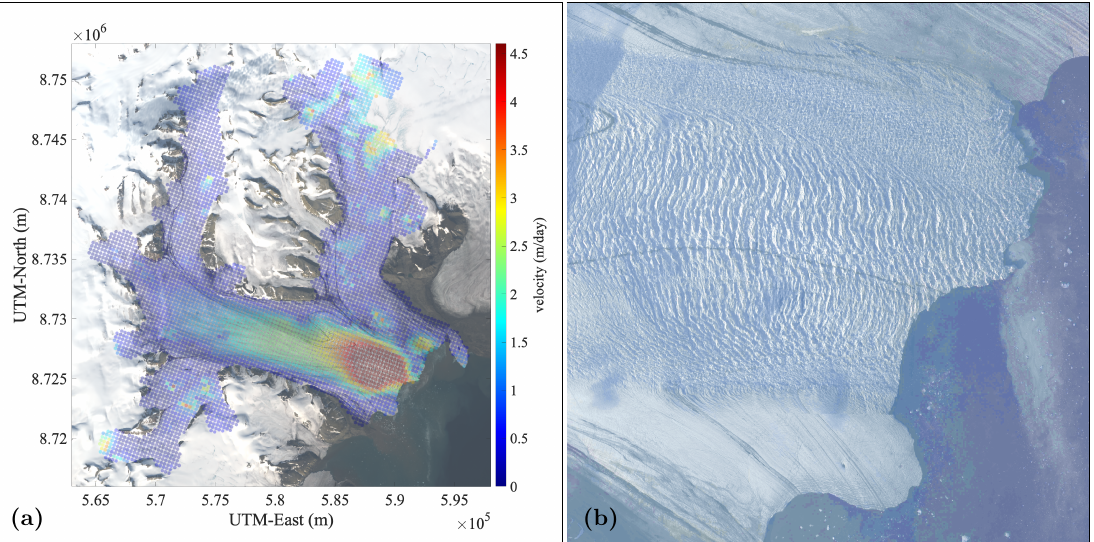
Figure 4. Negribreen velocity magnitude and crevassing at time of validation campaign in Au- gust 2019. ( a ) Velocity magnitude, calculated from ESA Copernicus Mission Sentinel-1 SAR data for 9 August 2019 to 21 August 2019. Highest velocity magnitude was 5.96 m/day near the calving front. ( b ) Crevasse types in the fastest-moving region near the front, Planet SkySat image, collected 18 August 2019. [20190818_150858_ssc9_u0002_panchromatic_dn.tif]. (Figure panel ( b ) after